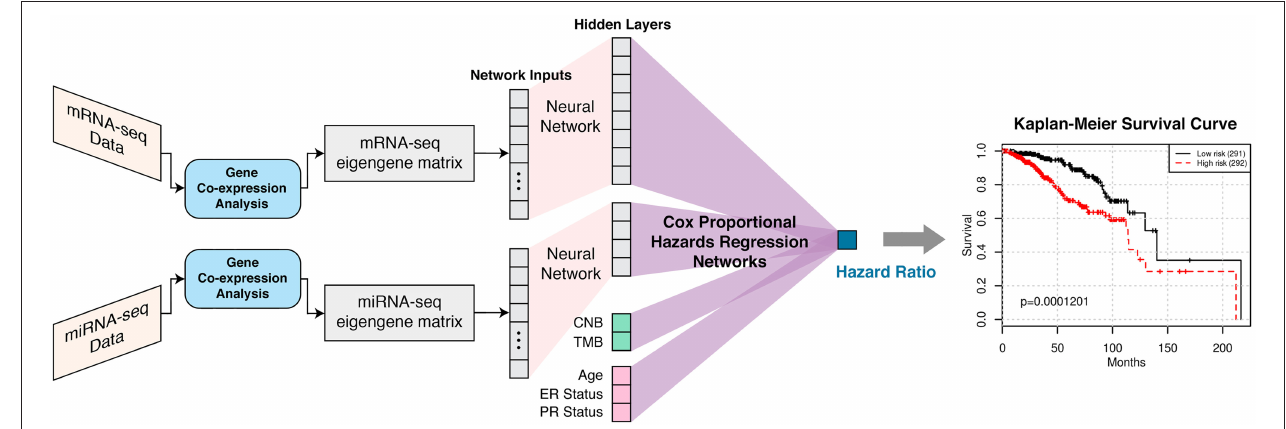
FIGURE 1 | SALMON (Survival Analysis Learning with Multi-Omics Neural Networks) architecture with the implementation of Cox proportional hazards regression networks. Co-expression modules (eigengene matrices) are the inputs to the SALMON. Number of the hidden layers and dimensions of hidden layers can also be fine-tuned (not included in this paper). The output is the hazard ratios which can be interpreted as the relative risks of patients.